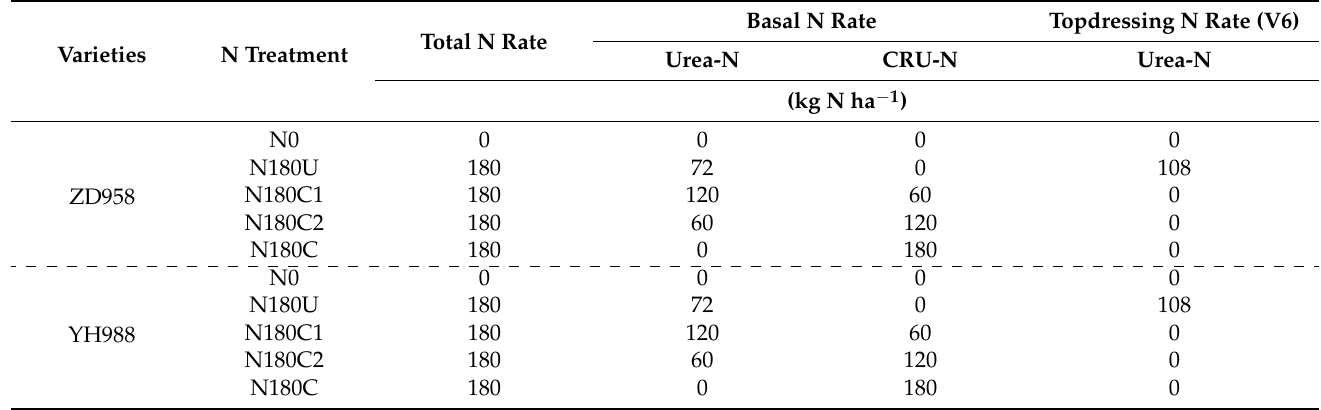
Table 1. Experimental design in 2019–2020 at the station of Yuanyang county (34°55 ′ N, 113°36 ′ E) in Xinxiang city, Henan Province, China.